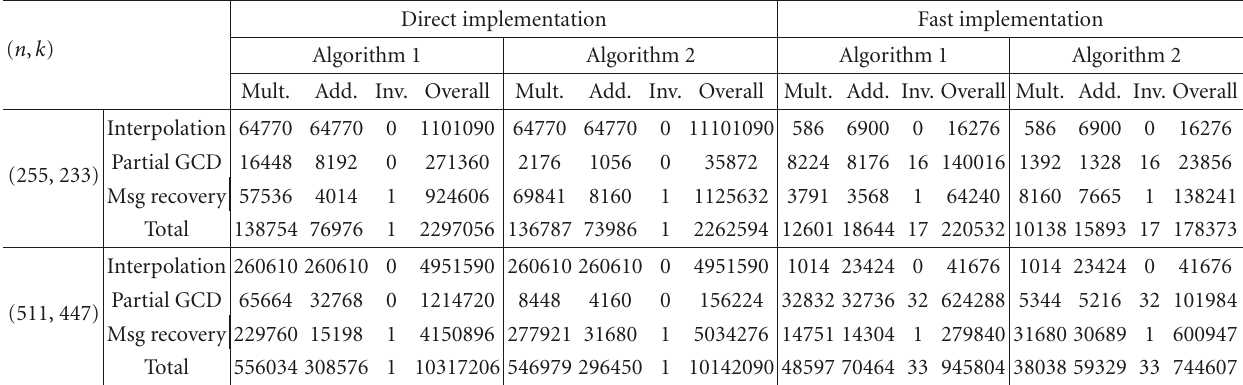
Table 5: Complexity of syndromeless decoding